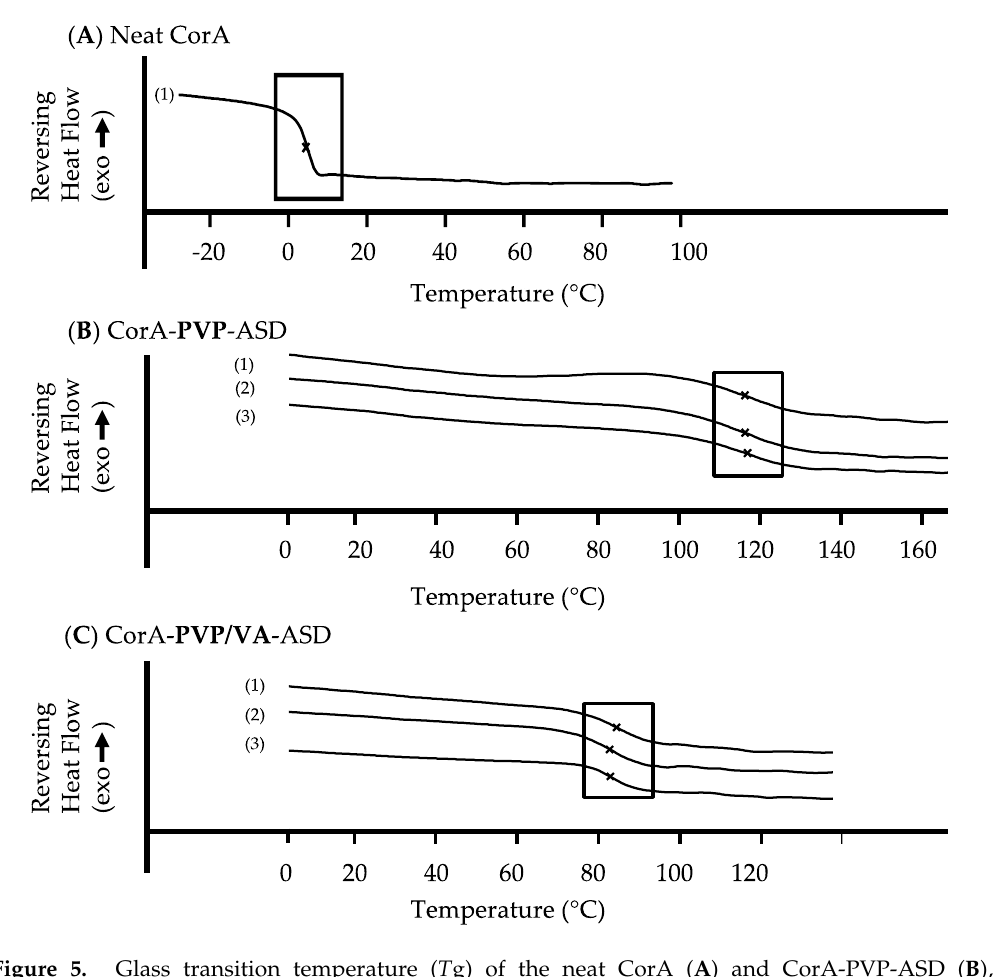
Figure 5. Glass transition temperature ( T g) of the neat CorA ( A ) and CorA-PVP-ASD ( B ), CorA-PVP / VA-ASD ( C ) formulations (1) and stability analysis testing after three months at 25 ◦ C / 60% RH (2) and 40 ◦ C / 75% RH (3). Table 3. Glass transition temperature ( T g) of the neat CorA, CorA-PVP-ASD and CorA-PVP/VA-ASD formulations, and the neat polymers PVP and PVP/VA.